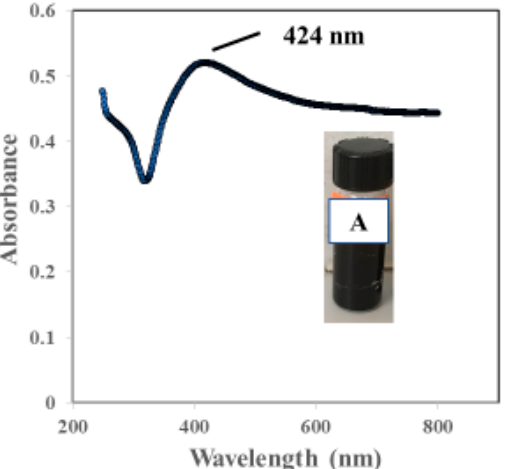
Figure 2. UV-Vis spectrum of the AgNps synthesized by novel method. Figure 2. UV ‐ Vis spectrum of the AgNps synthesized by novel method.